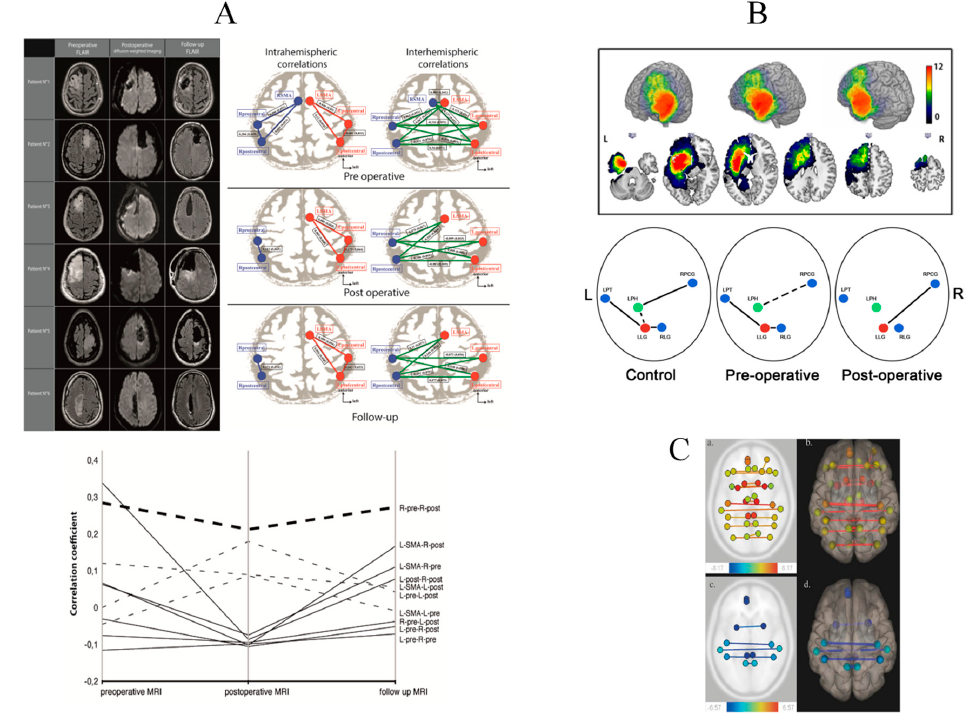
Figure 1. Serial fMRI before and after LGG resection ( A ): perioperative motor reorganization (from [106]). Left: Preoperative FLAIR-weighted MRI (left column), immediate postoperative diffusion-weighted MRI (center column) and delayed postoperative FLAIR-weighted MRI in 6 patients who underwent resection for an LGG involving the SMA. Right: Evolution of correlation maps within the resting-state sensorimotor network. Correlation coefficients between the sensorimotor network nodes, at both intra-hemispheric ( left column ) and inter-hemispheric ( right column ) levels, in the preoperative period ( top ), in the immediate postoperative period ( center ), and at 3 months’ follow-up ( bottom ). In both hemispheres, network nodes include the precentral region, the postcentral region, and the SMA; the SMA was resected on the lesional side and is therefore absent postoperatively. Lower: Longitudinal evolution plot of inter- and intra-hemispheric correlations in the sensorimotor network. The time course of all intra-hemispheric ( dashed lines ) and inter-hemispheric ( continuous